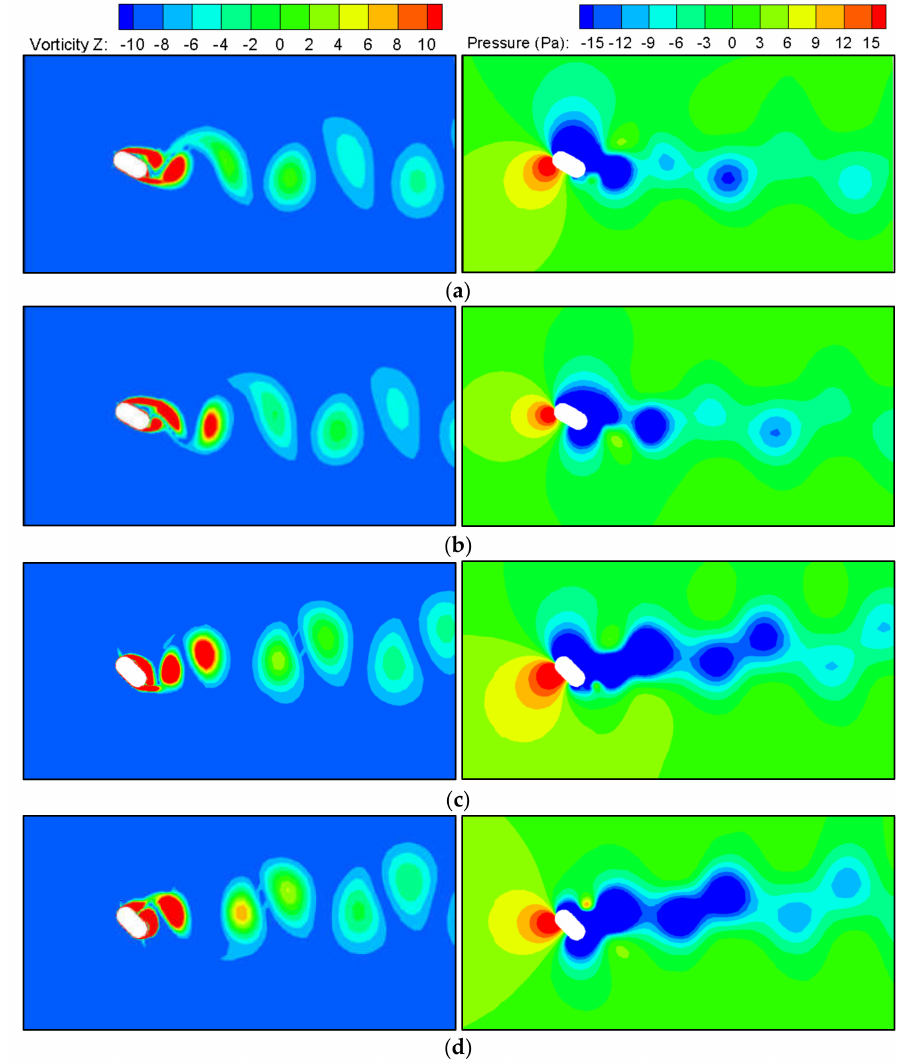
Figure 25. Vorticity field and pressure field distribution diagrams of the flow around a circular-ended